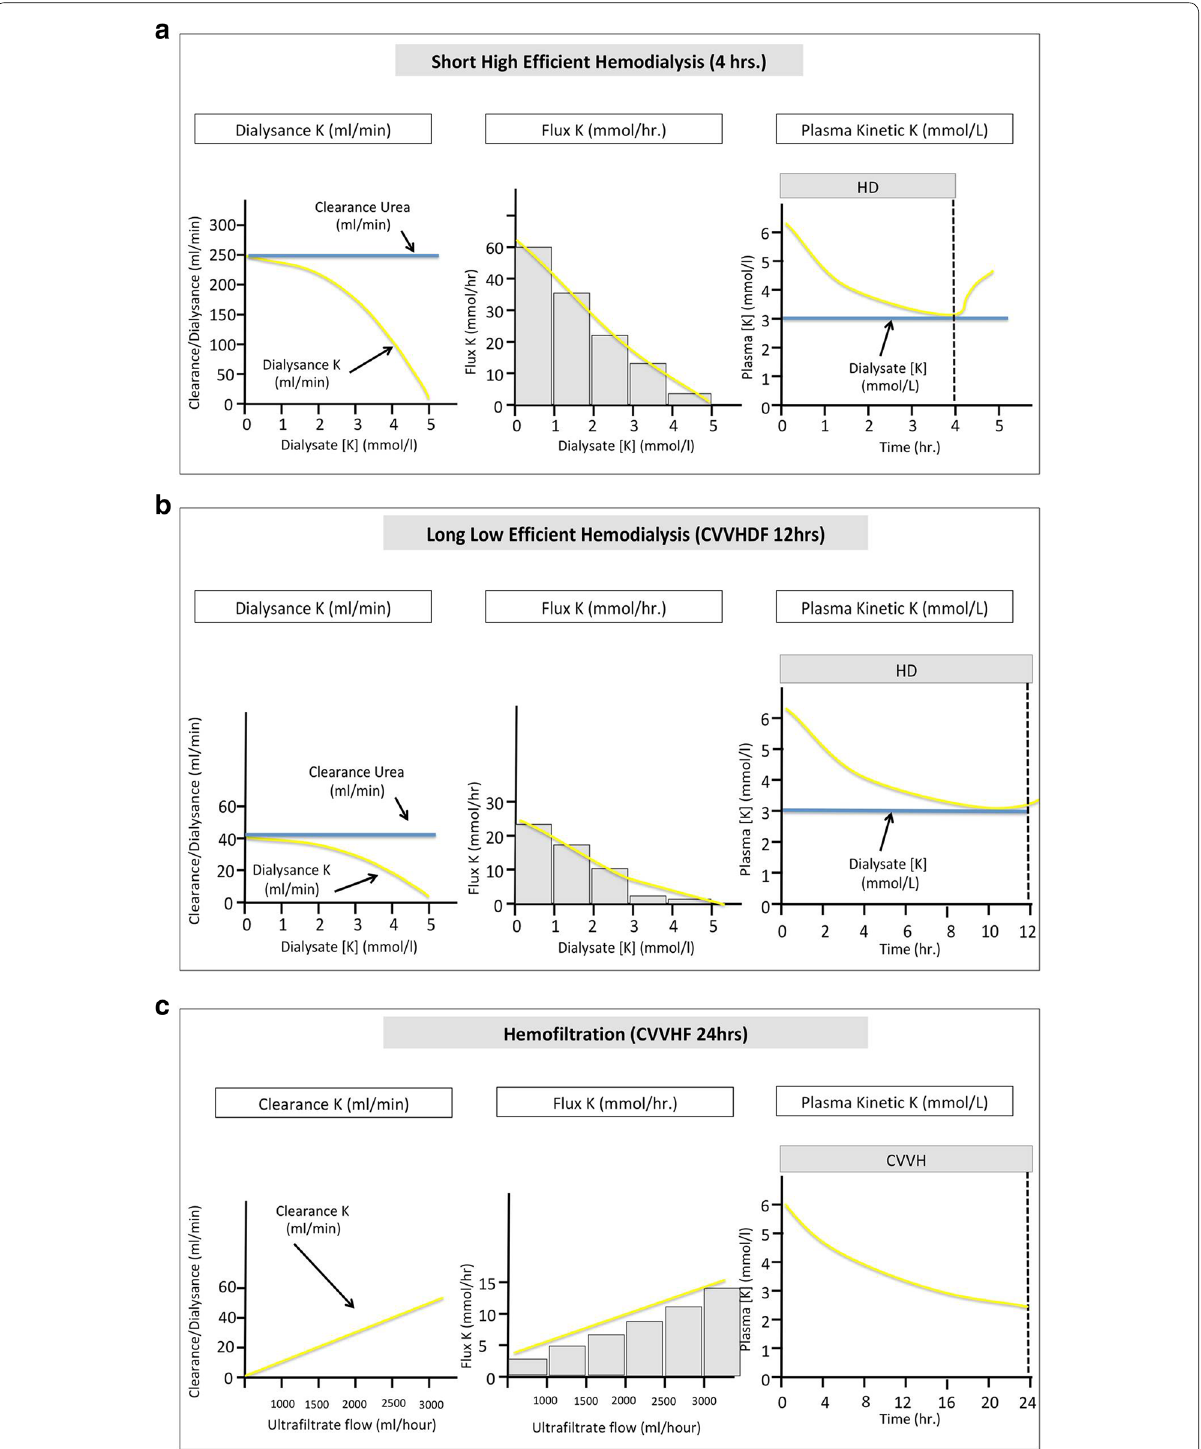
Fig. 4 Action mechanisms of hypokalemic treatments by intracellular transfer. a Potassium dialysance, flux and plasma kinetic under short high efficient hemodilaysis. b Potassium dialysance, flux and plasma kinetic under long low efficient hemodilaysis. c Potassium clearance, flux and plasma kinetic under hemofiltration. K potassium, CVVHD continuous venovenous hemodialysis, CVVHF continuous venovenous